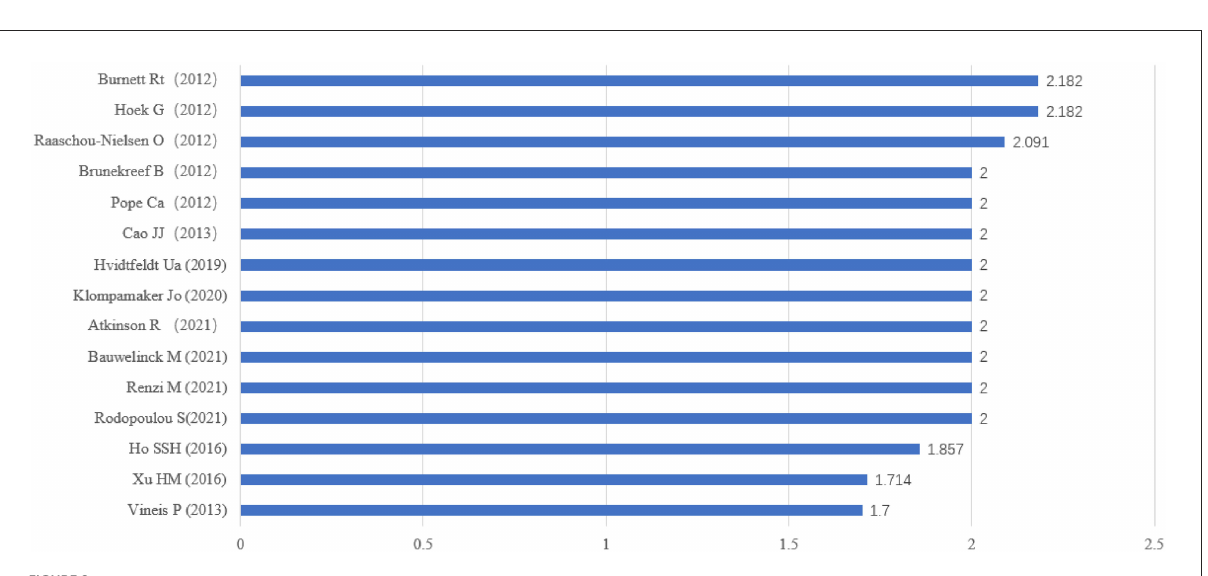
FIGURE2 Top 15 authors in M index order enclosed the first publication